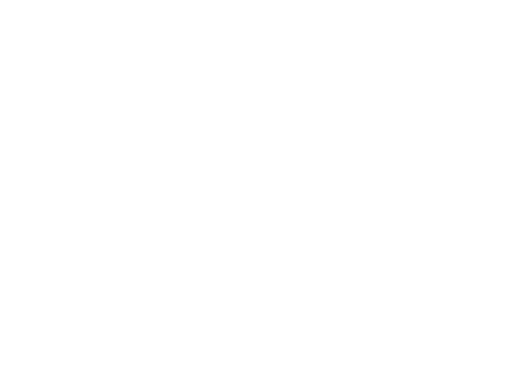
Adsorption isotherms Parameters Parameter